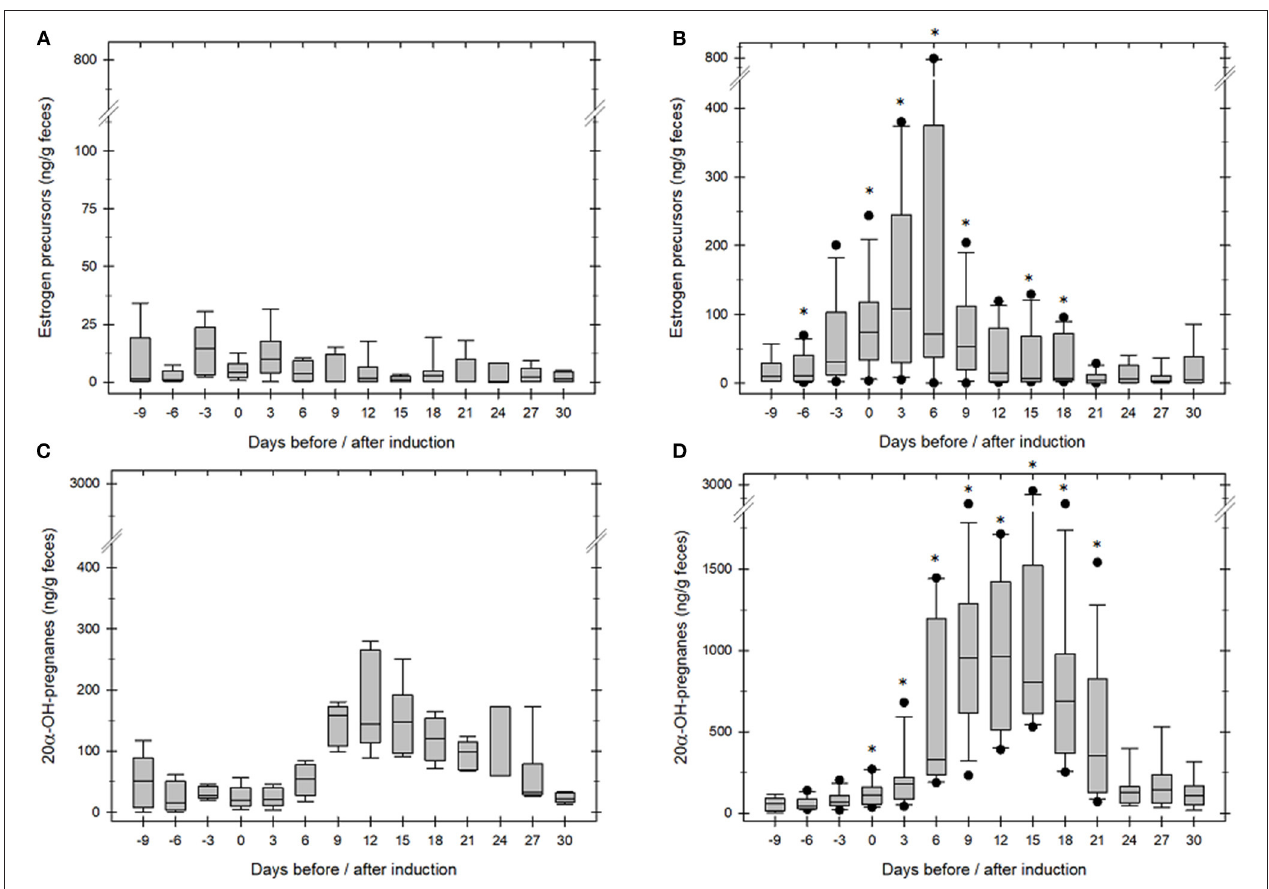
TABLE 1 | Two-tailed P -values of the comparisons between high and low estrogen and pregnane concentrations during ovulation induction ( n = 11) in one GOH rhinoceros. Fecal metabolite − 9 d − 6 d − 3 d 0 d 3 d 6 d 9 d 12 d Estogen > 0.05 = 0.02 > 0.05 > 0.05 Pregnane